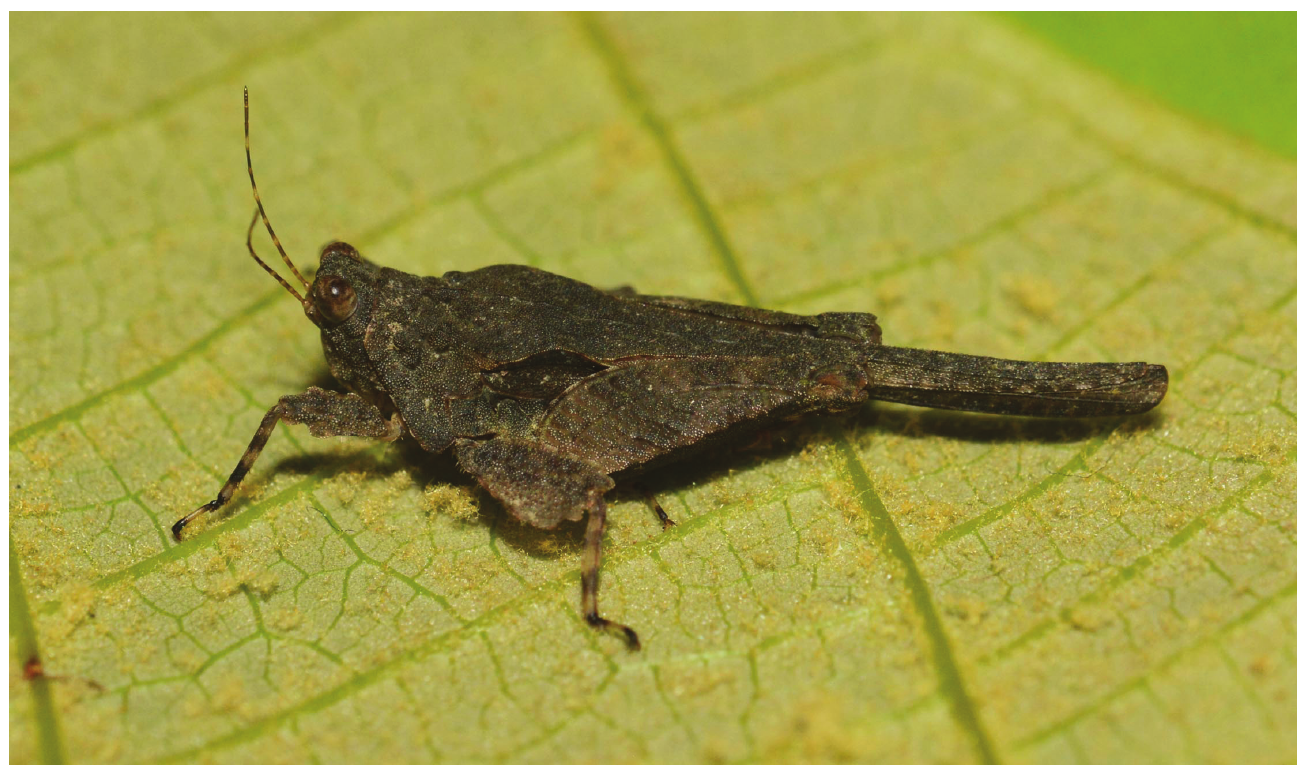
Fig. 7. Live Eomorphopus granulatus from Brazilian Amazon .